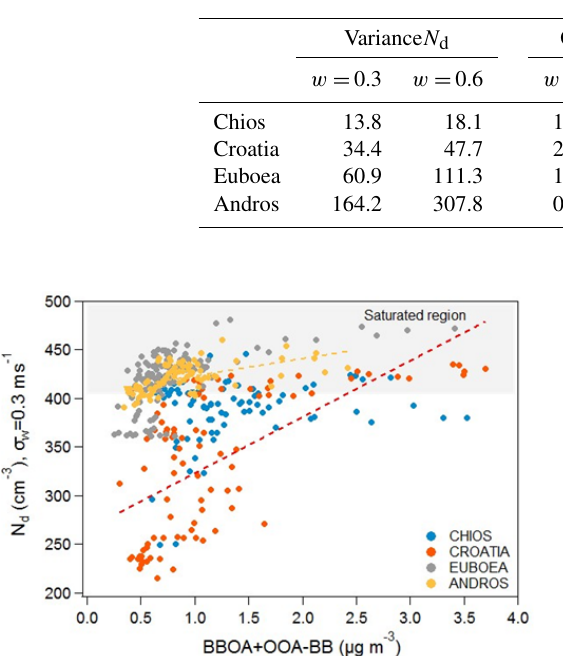
Table 5. Variance of N d and relative contribution to this variance of aerosol number and chemical composition for the four fire events.